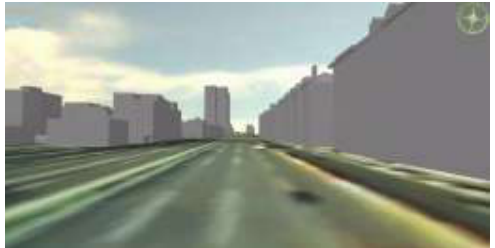
Figure 3. 3D model reconstructed through aerial